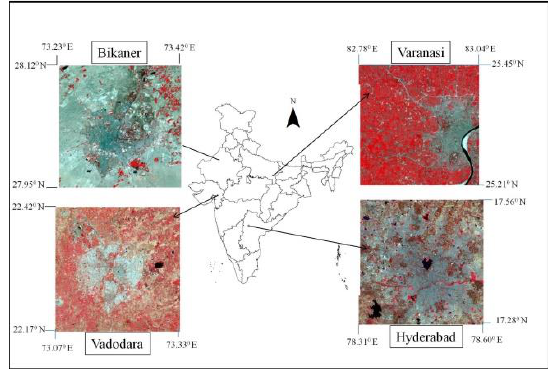
Figure 1. Location map of study